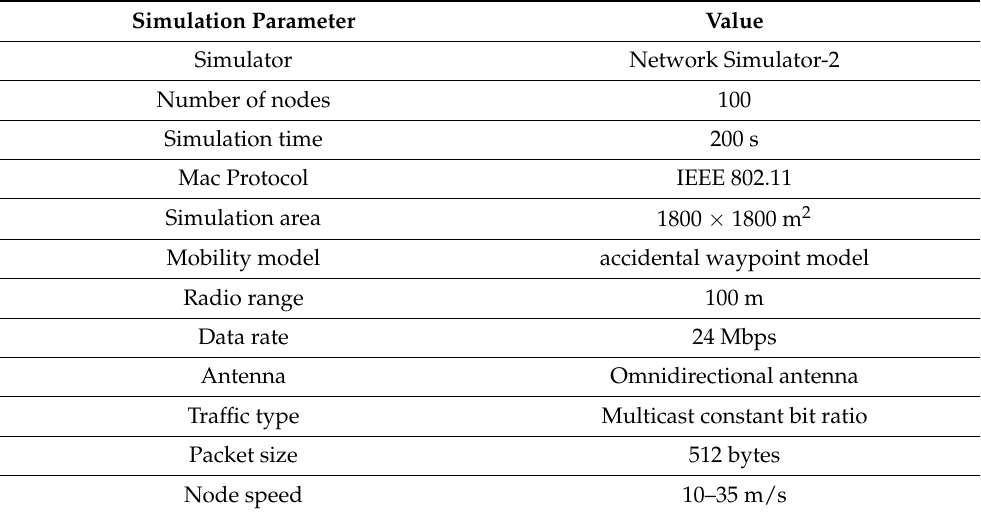
Table 1. Simulation parameters and their